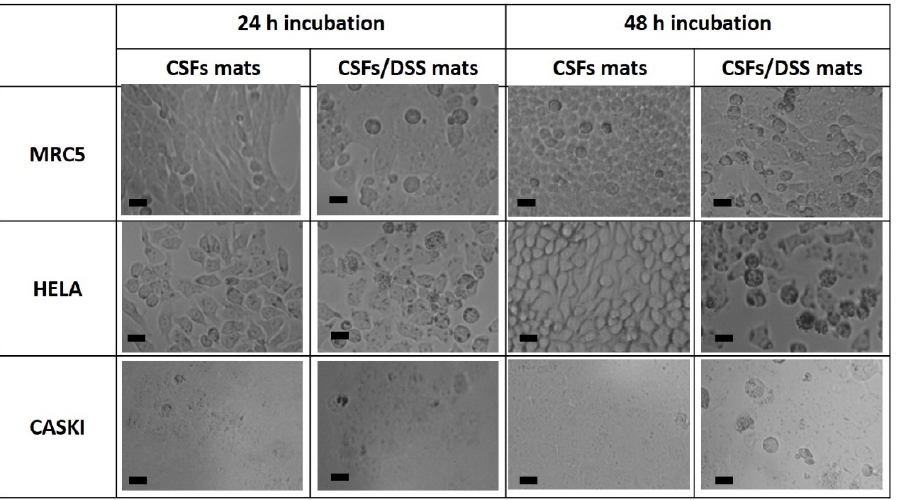
Figure 7. Microscopy images of cell line morphology. The scale bar corresponds to 20 μ m.